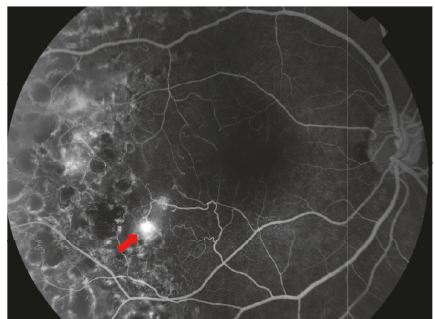
Figure 4: Fundus fluorescein angiogram of the right eye carried out 4 years before development of polypoidal lesions. Macular ischaemia is evident, together with active retinal neovascularization in the infero-temporal macula (red arrow). Previous laser retinal scars are also visible